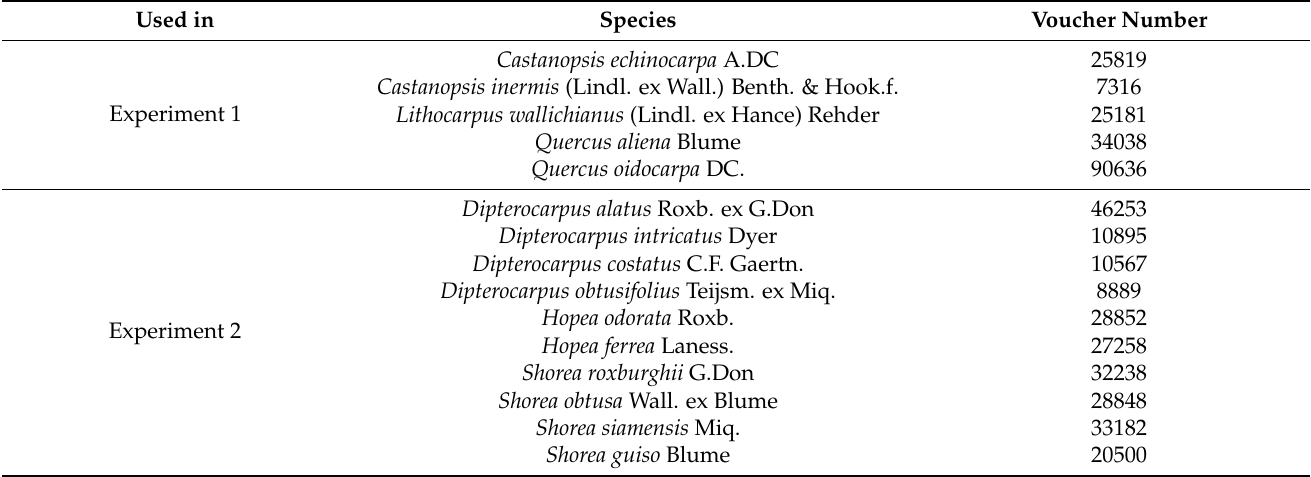
Table 1. Details of the plant